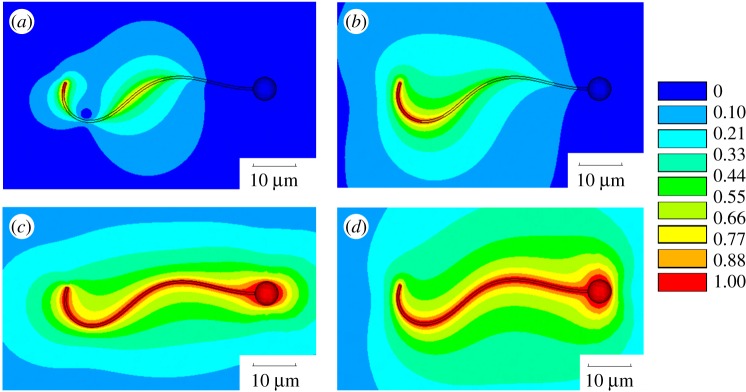
Absolute velocity distribution in the plane of the swimmer for four elementary motions: (a) a flexibly moving flagellum in the reference frame fixed with the swimmer head, (b) the swimmer rotating about the head centre as a rigid body, (c) the swimmer is rectilinearly moving in the streamwise direction as a rigid body and (d) the swimmer is rectilinearly moving in the transverse direction as a rigid body.